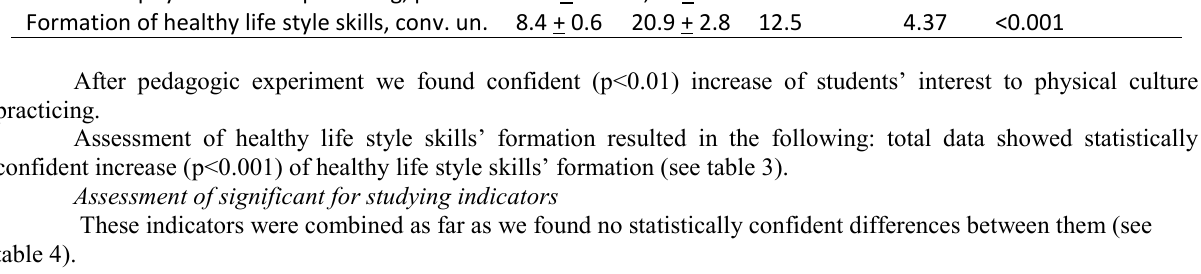
Table 4. Indicators of students’ pedagogic characteristics (M+m) Indicators